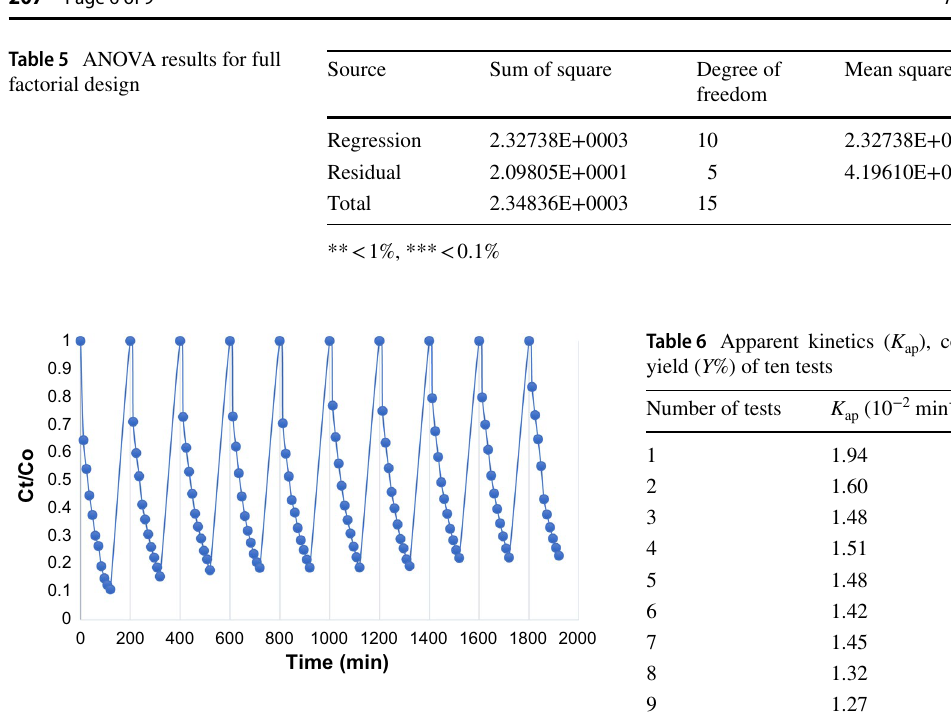
Fig. 6 Kinetics of RhB discoloration for ten solutions treated with TiO 2 /β-SiC foam